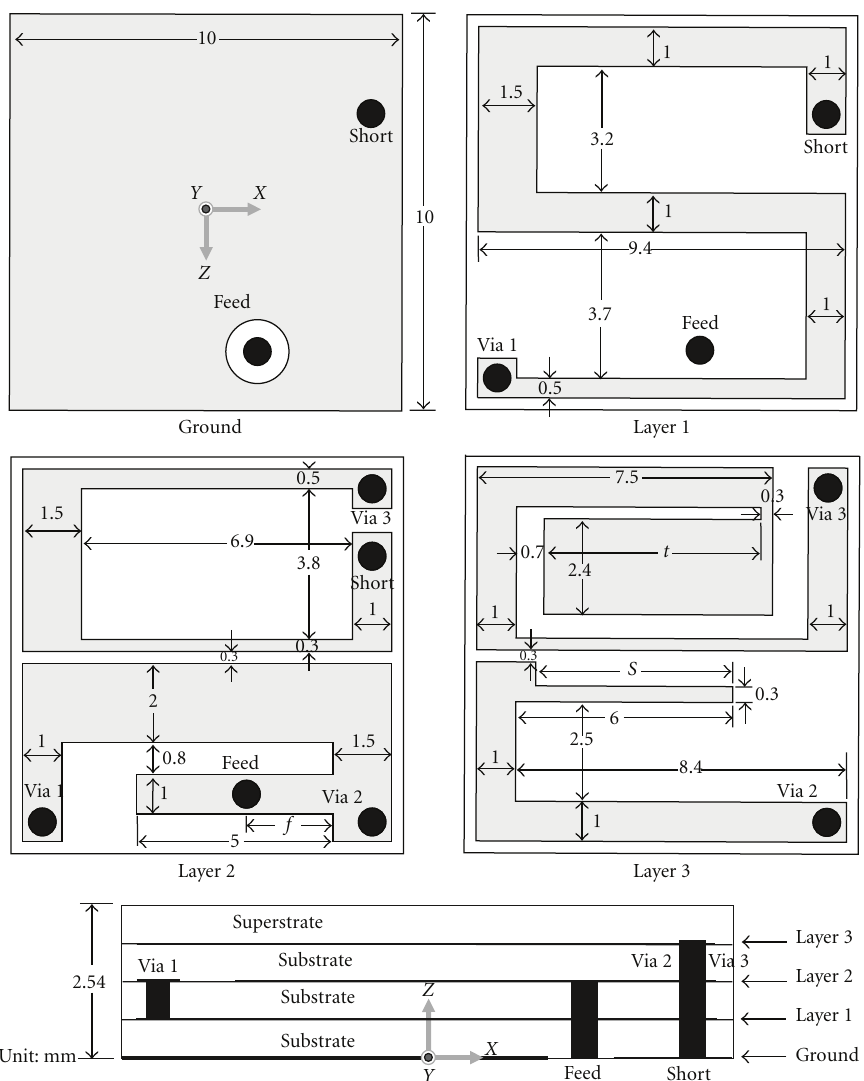
Figure 1: Geometry of the proposed